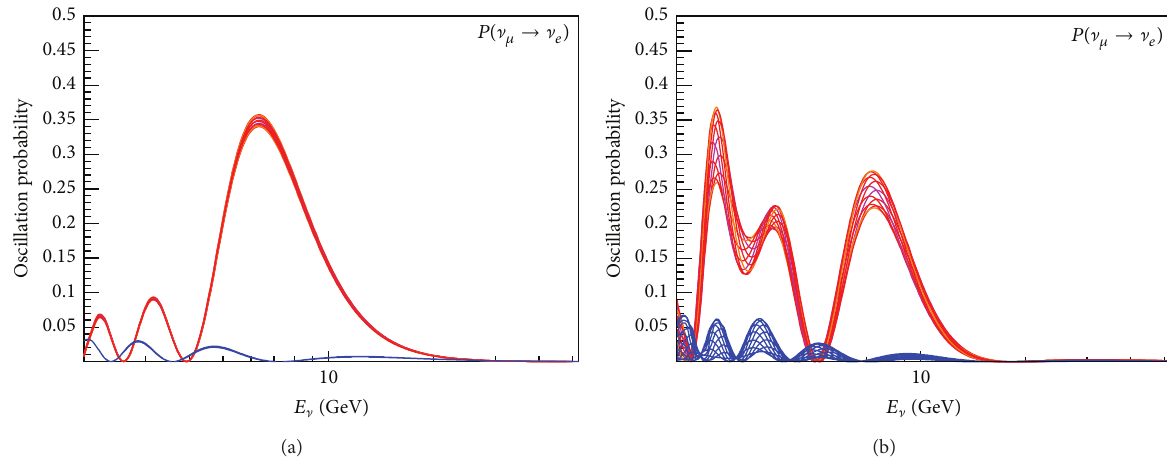
Figure 10: Neutrino oscillation probabilities 𝑃( ] 𝜇 → ] 𝑒 ) parameters from a global fit as a function of neutrino energy for baselines of 7675 km (a) and 11468km (b) which corresponds to cos Θ = 0.6 and 0.9, respectively. The group of red lines is for NH, blue for IH and 𝜙 varied in steps of 30 ∘ between 0 ∘ and 330 ∘ .